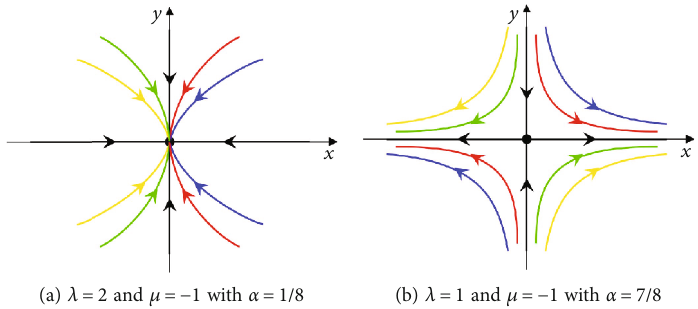
Figure 4: The phase portraits of system (8) for λ > 0 > μ at di ff erent α